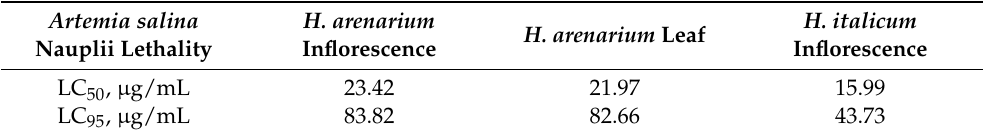
Table 5. Toxic activity of H. arenarium and H. italicum essential oils. Artemia salina Nauplii Lethality